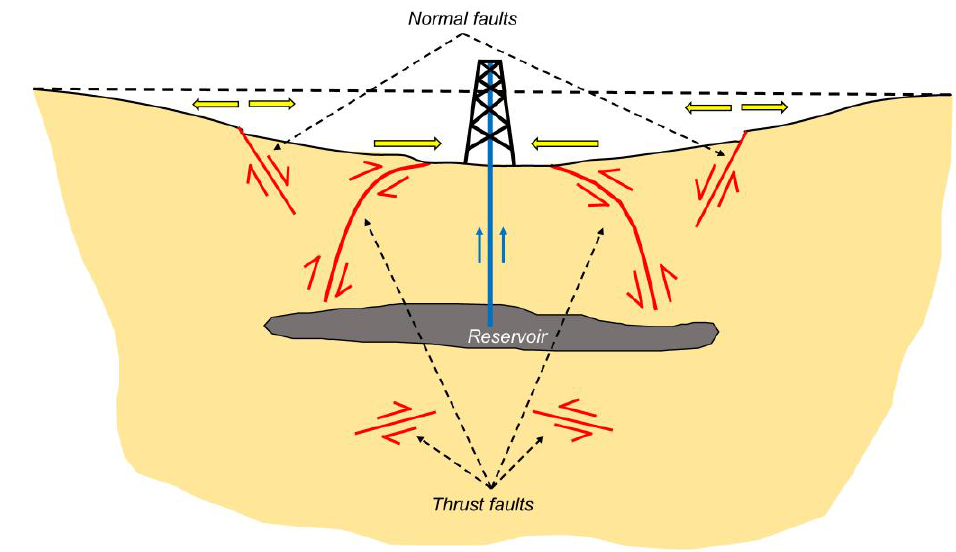
Figure 8. Schematic cross section (modified from Odonne et al., [41]) summarizing the surface deformation and faulting (red lines) associated with fluid withdrawal. Normal faults develop on flanks of field while reverse faults develop over and below reservoir, and close to Earth’s surface. The yellow arrows indicate horizontal displacement at Earth’s surface.